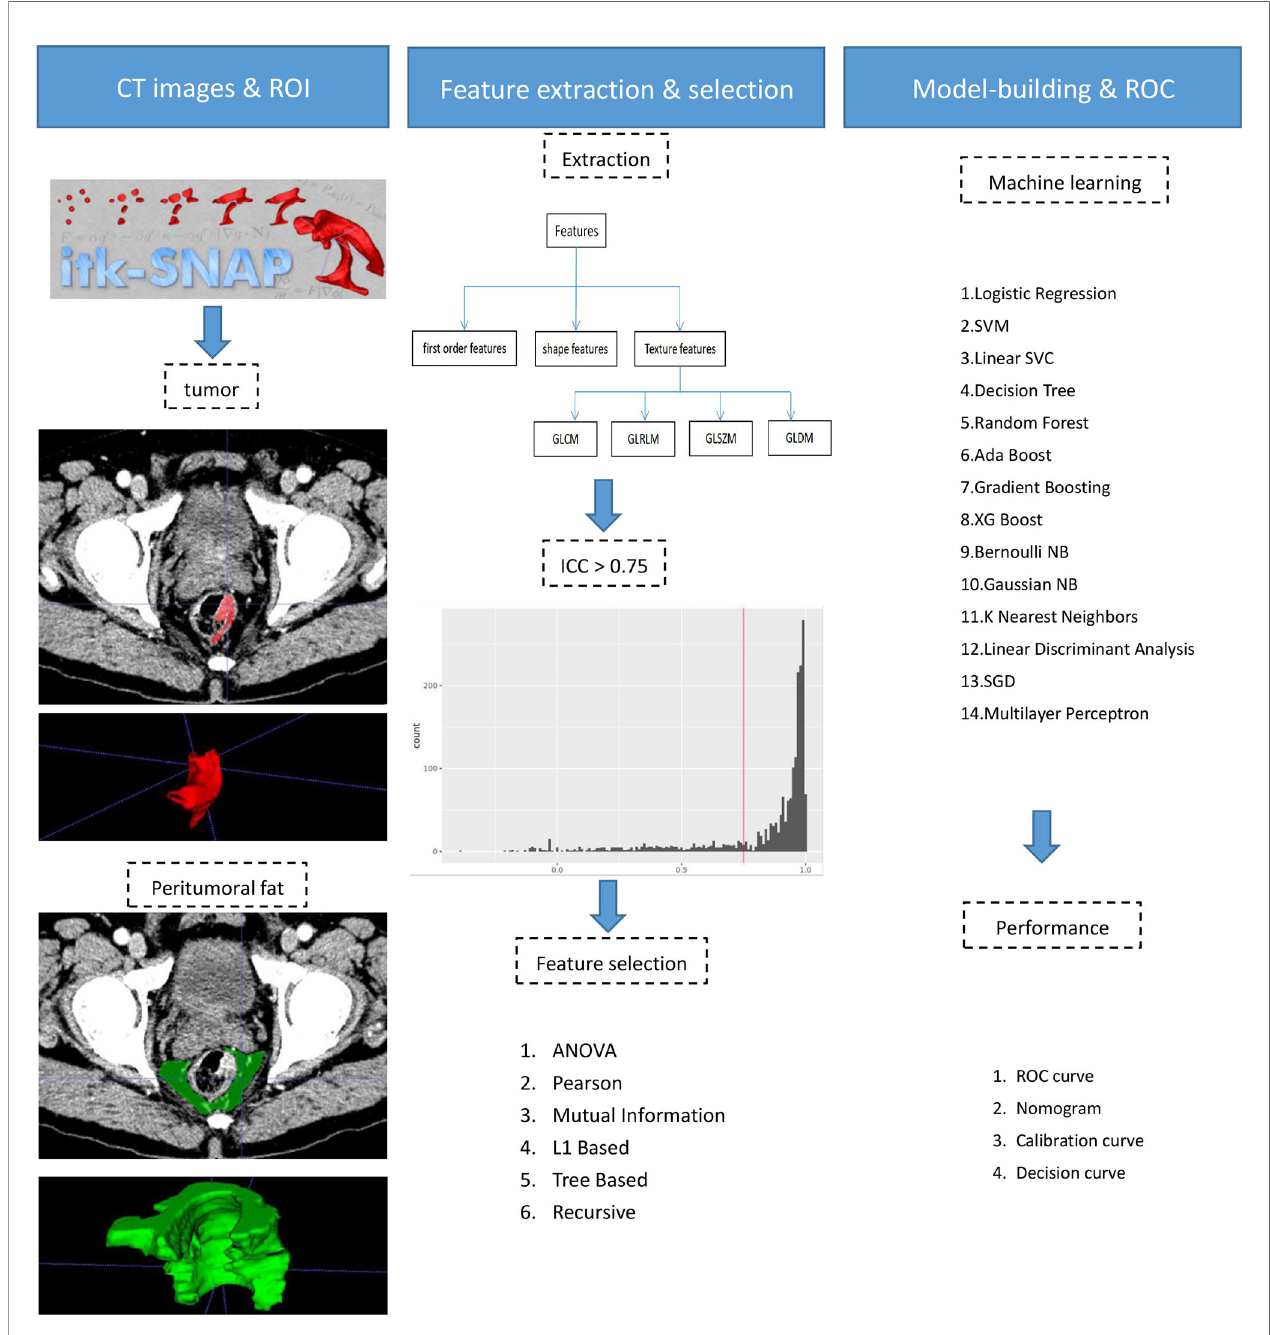
FIGURE 2 | Radiomics work fl